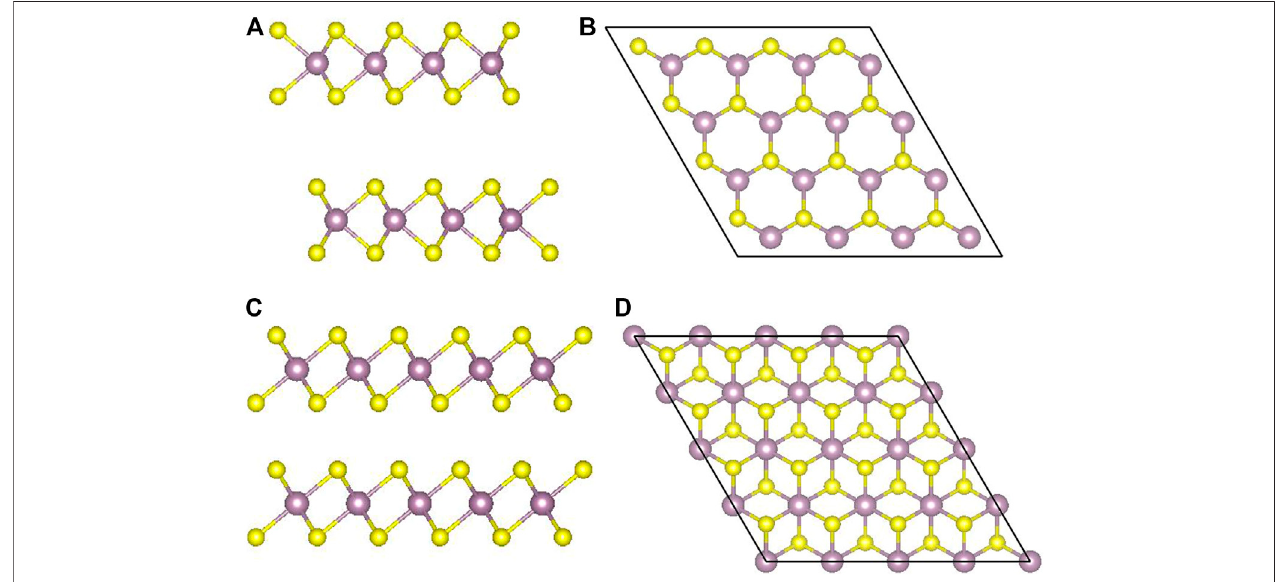
FIGURE 1 | 1T- and 2H-phase MoS 2 : (A) and (B) the layered structure of 2H-MoS 2 and the top view in z direction; (C) and (D) the same for 1T-MoS 2 .